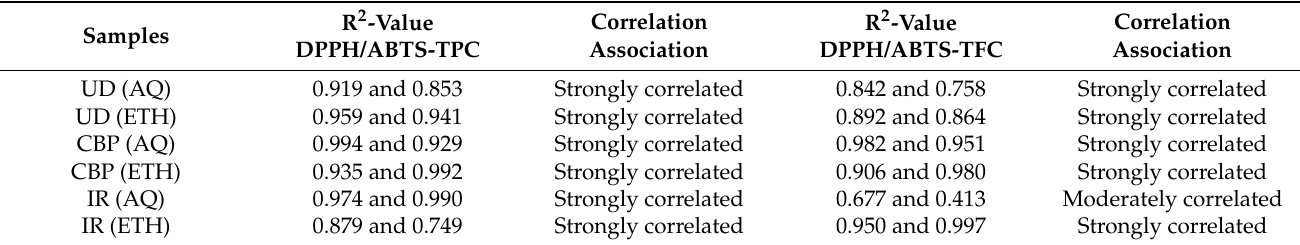
Table 1. Illustration of the correlation coefficient (R 2 -value) between the antioxidant ability through DPPH and ABTS assays with the TPC and TFC of aqueous (AQ) and ethanolic (ETH) fractions of Urtica dioica (UD), Capsella bursa-pastoris (CBP) and Inula racemosa (IR).